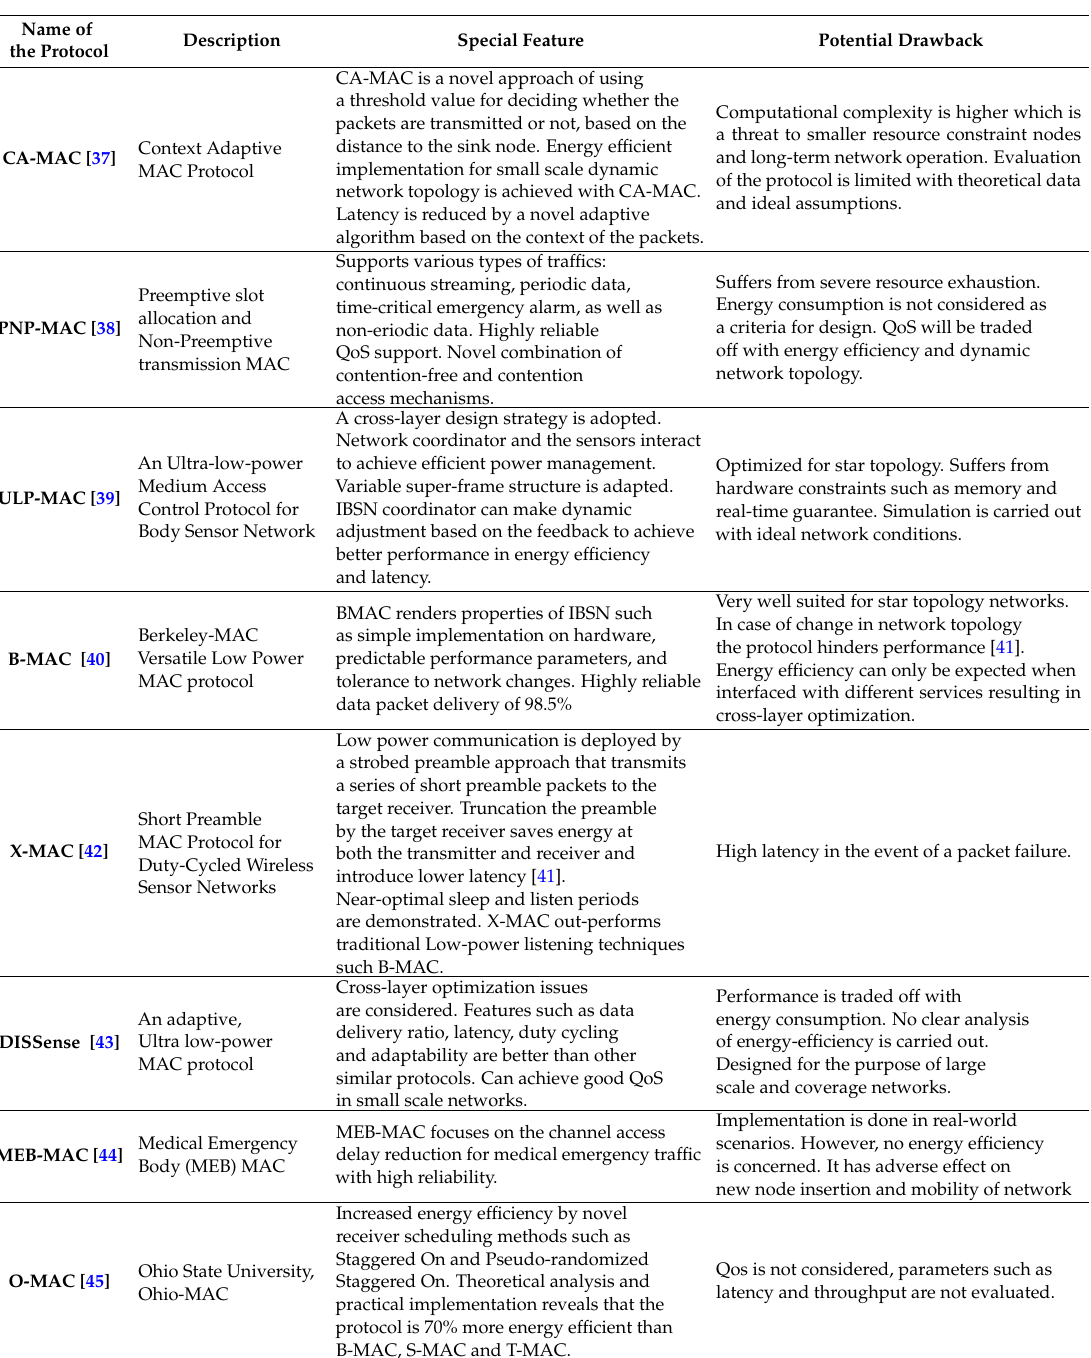
Table 7. CSMA-based MAC protocols without WuR and their drawback for